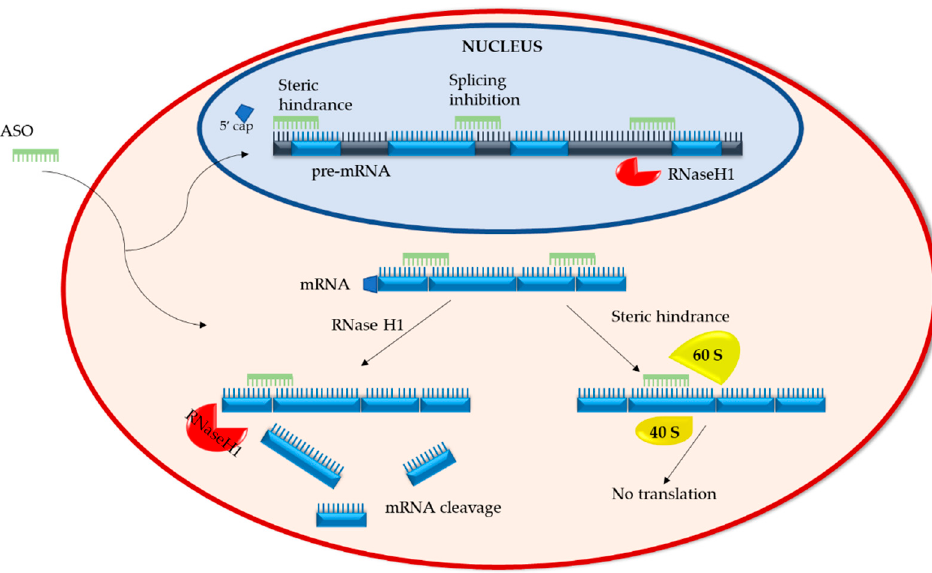
Figure 1. Antisense oligonucleotide mechanisms of action. ASOs interfere with pre/mRNA in two ways: (i) by promoting their cleavage via RNaseH1 and (ii) by blocking processing events such as 5 ′ capping of the pre ‐ RNA, exon splicing, and the interaction of mRNA with ribosomal subunits (40S and 60S) of the translation initiation complex.